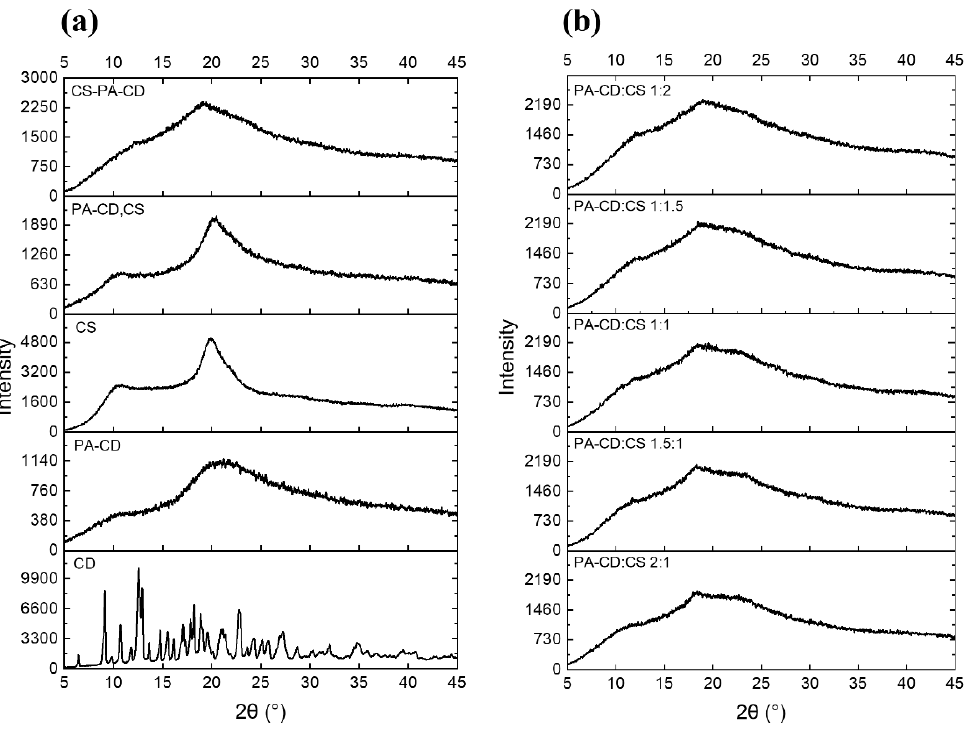
Figure 2. XRD patterns of ( a ) β -CD, PA-CD, CS, physical mixture of PA-CD and CS and ( b ) CS-PA-CD nanoparticles with different ratios.